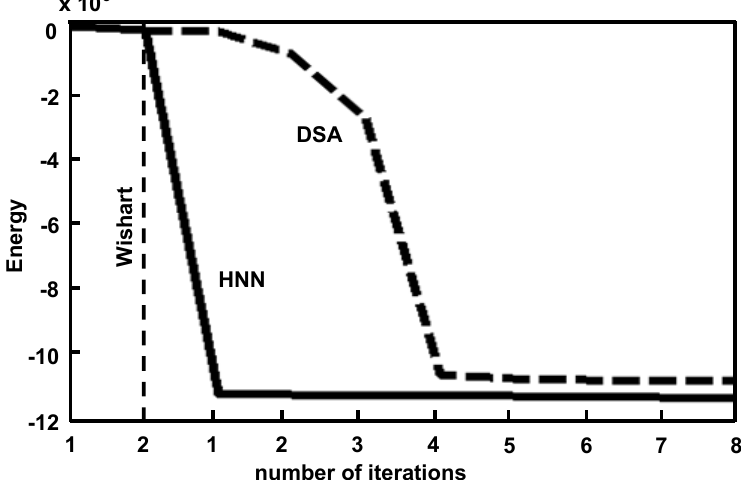
Figure 3. Energy variation against the number of iterations for Wishart and